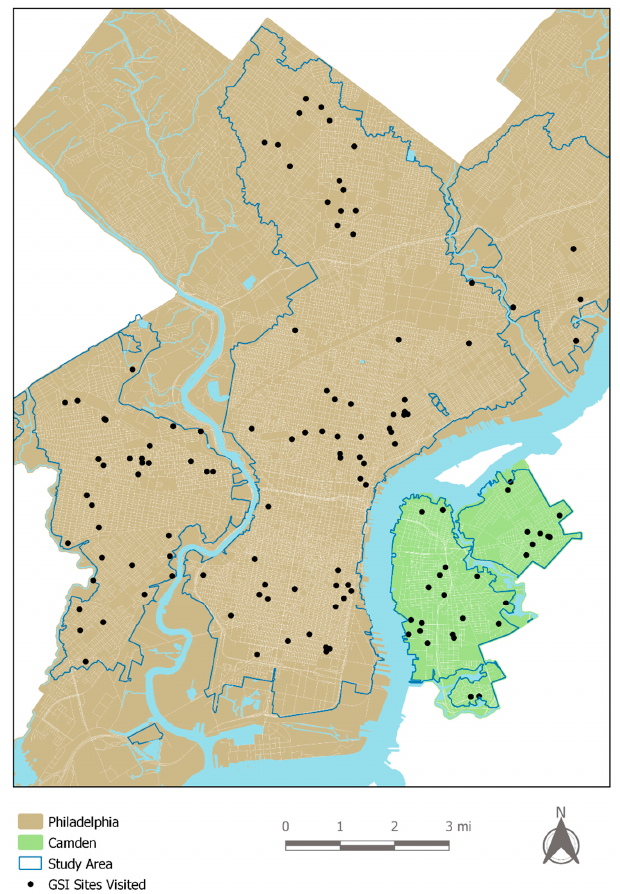
Figure 1. GSI sites visited in Philadelphia and Camden. Data sources: US Census Bureau, Open Data Philly, New Jersey Department of Environmental protection, New Jersey Geographic Information Network, and Delaware Valley Regional Planning Commission. Map by Shane